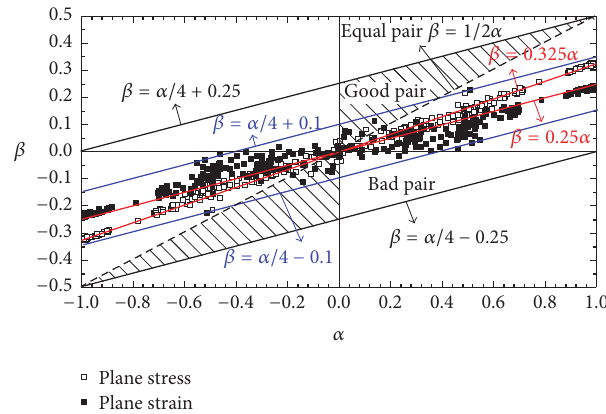
Figure 5: Dundurs parameters for typical engineering materials